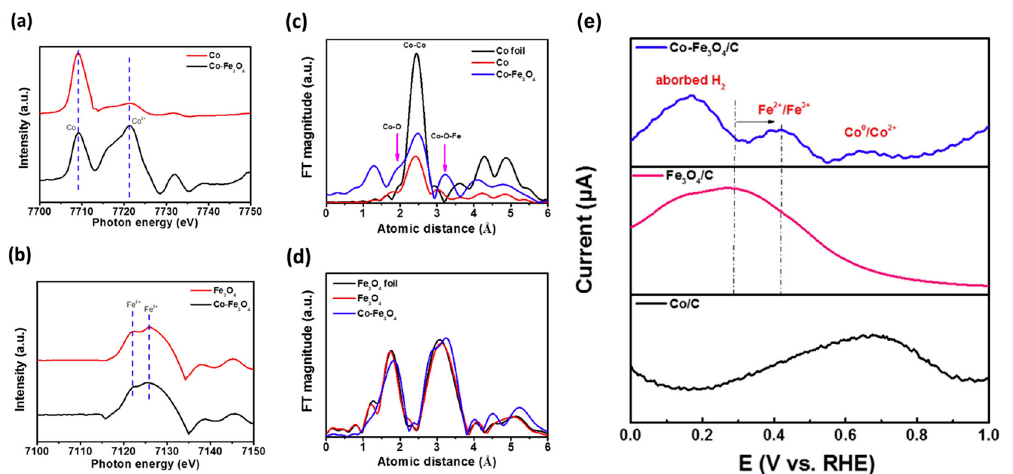
Figure 15. XANES spectra for ( a ) Co K-edge and ( b ) Fe K-edge; extended X-ray absorption fine structure (EXAFS) spectra for ( c ) Co K-edge and ( d ) Fe K-edge, ( e ) square wave voltammetry (SWV) curves of Co–Fe 3 O 4 / C, Fe 3 O 4 / C, and Co / C tested in 0.1 M KOH, reproduced with permission from [82]. Copyright Elsevier,